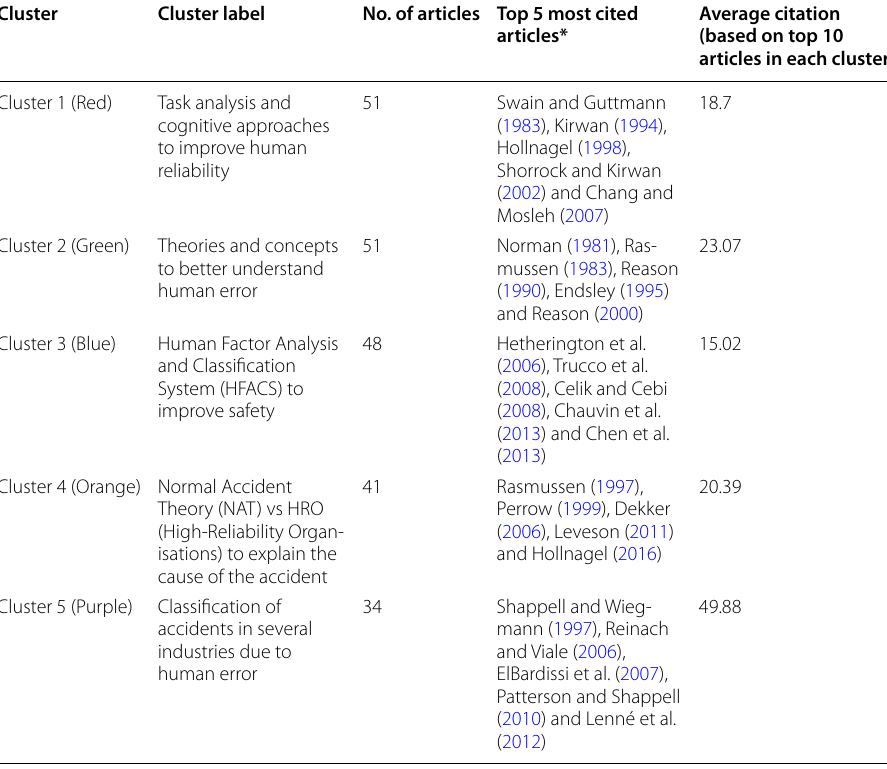
Table 3 References output indicators and citation impact related to stage 2 and Fig.